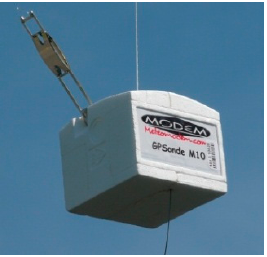
Figure 3. M10 radiosonde.